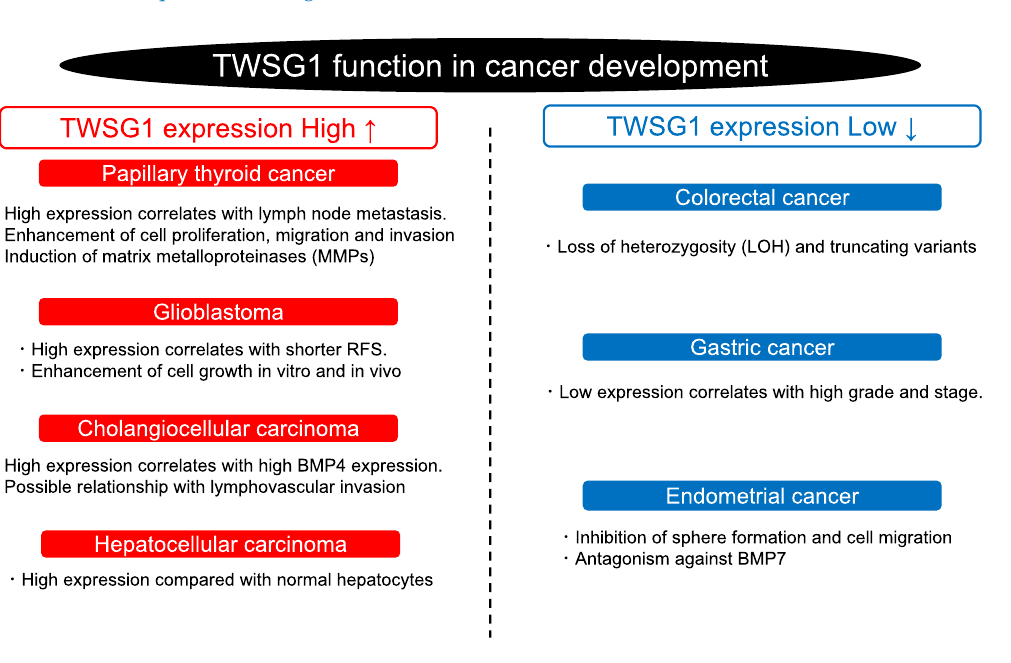
Figure 3. TWSG1 mRNA expression in various types of cancers. The mRNA expression profiles of TWSG1 in various types of cancers were acquired from the Human Protein Atlas (https://www.proteinatlas.org/ accessed on 11 October 2022 ) .